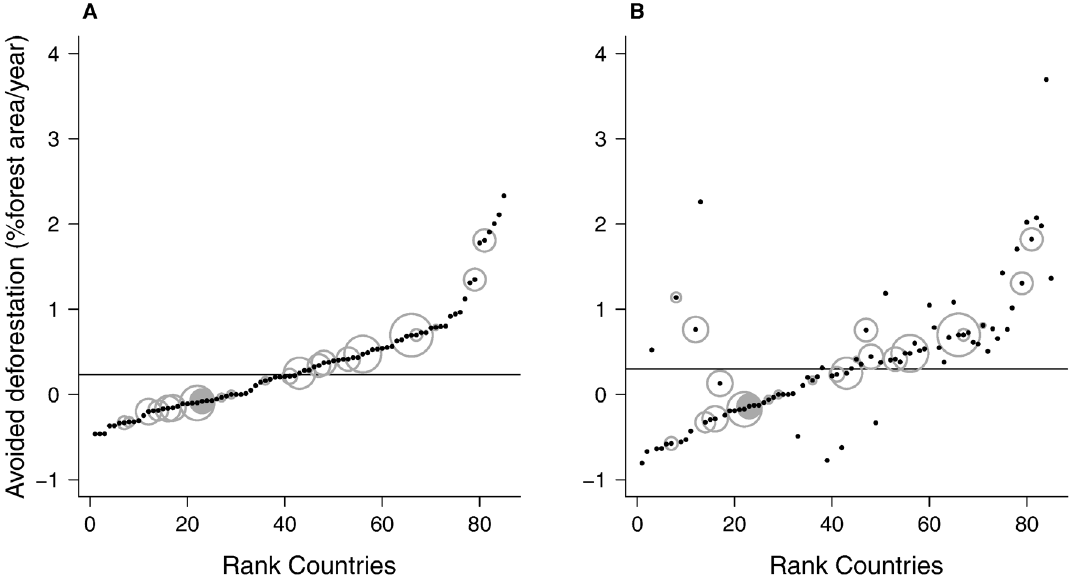
Figure 4. Deforestation avoided by REDD + per country, expressed in percentage of forest area per year. Two possible scenarios are presented; a) not valuing biodiversity and b) attributing a maximum value of up to $ 10,000 per hectare. Countries are ranked by the percentage of avoided deforestation in the scenario a). An horizontal line signals worldwide deforestation avoided in both scenarios; 0.23 and 0.30% respectively. Grey circles show the logarithm of base 10 of the number of endemic forest bird island species for each country, with STP represented by the grey- filled circle. Negative values indicate that REDD + is promoting deforestation, instead of avoiding.